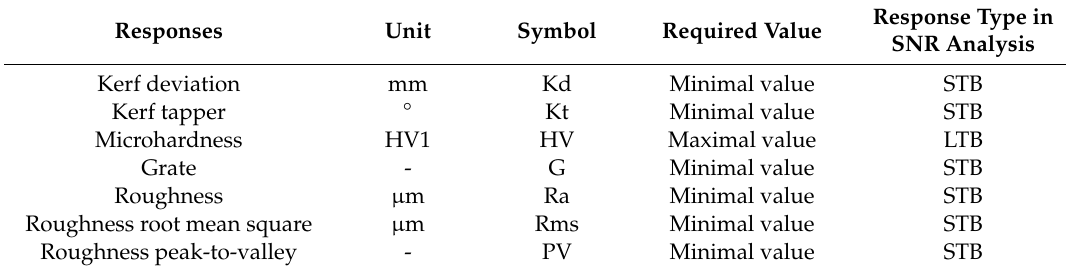
Table 3. Response specifications.